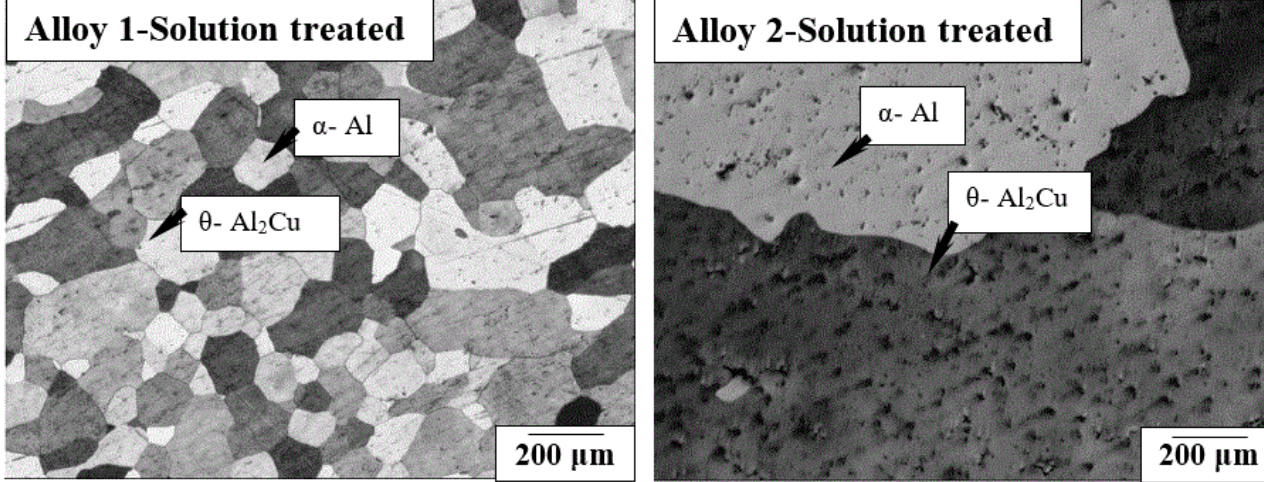
Figure 4. Cross-sectional optical microscopy (OM) observations of the solution-treated (Sol. treated) Al-Cu-Mg-Ag alloys showing mainly the α -Al (matrix) and black-colored θ -Al 2 Cu (precipitates).